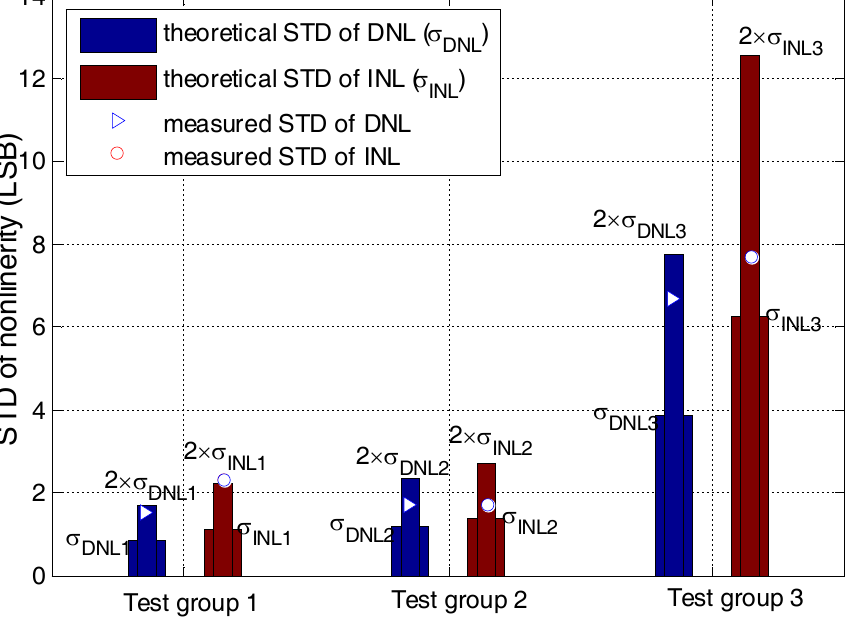
Figure 13. The comparison between the theoretical calculated nonlinearity and the measured nonlinearity. The theoretical calculation of nonlinearity is computed using the measured relative precision variances in Table 2 and Equations (10) and (14).